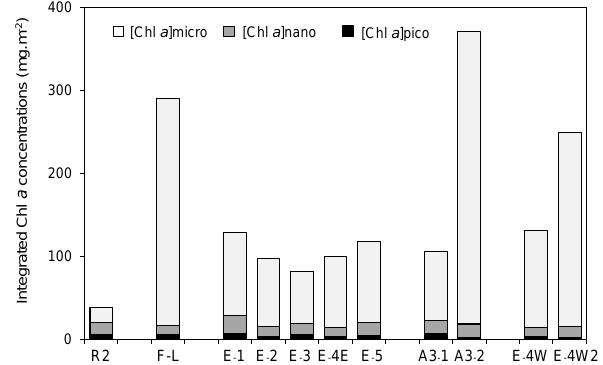
Figure 7. Figure 7. Temporal evolution of chlorophyll a concentrations associated with micro- ([chlorophyll a ]micro), nano- ([chloro- phyll a ]nano) and picophytoplankton ([chlorophyll a ]pico) within 200m at the complex system of recirculation (five visits chrono- logically numerated: E-1 (10/29), E-2 (11/01), E-3 (11/03), E-4E (11/13), E-5 (11/19)), at the plateau reference station A3 (two vis- its: A3-1 (10/20) and A3-2 (11/16)) and at station E-4W (two vis- its: E-4W (11/12) and E-4W2 (11/18)). The station F–L (integrated within 150m) and the HNLC reference station R2 are presented for